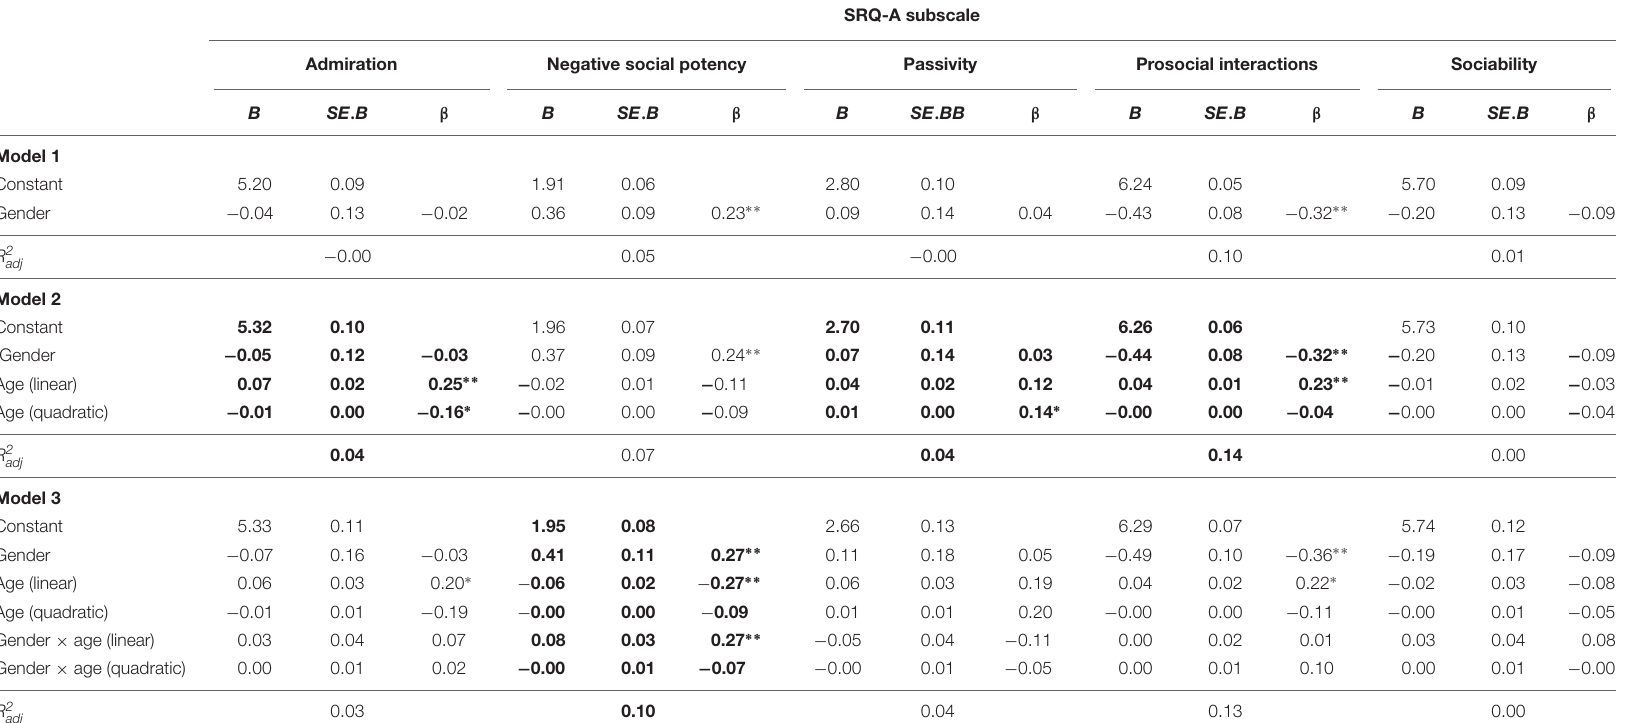
TABLE 5 | Regression analysis (enter method) per subscale